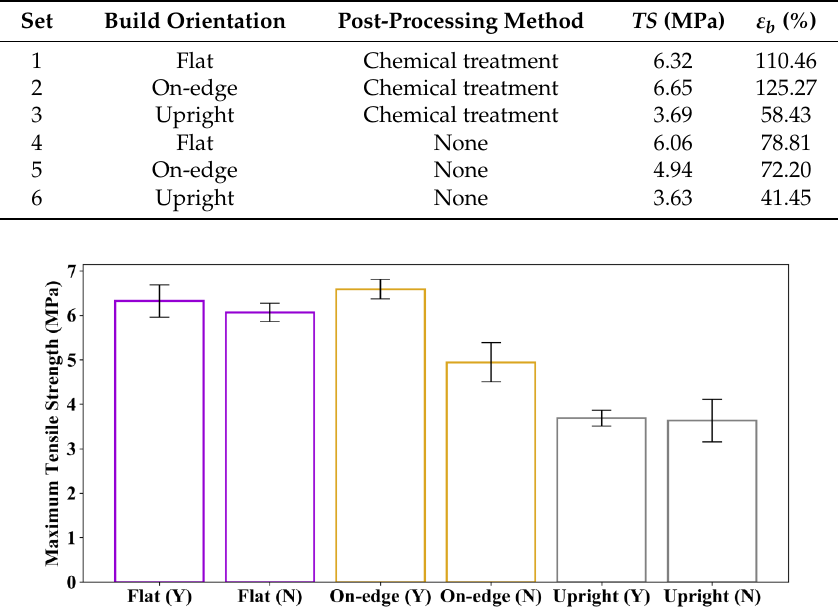
Figure 12. Comparison of the average maximum tensile strength. ”Y” indicates specimens with post-processing, and ”N” means specimens without post-processing.